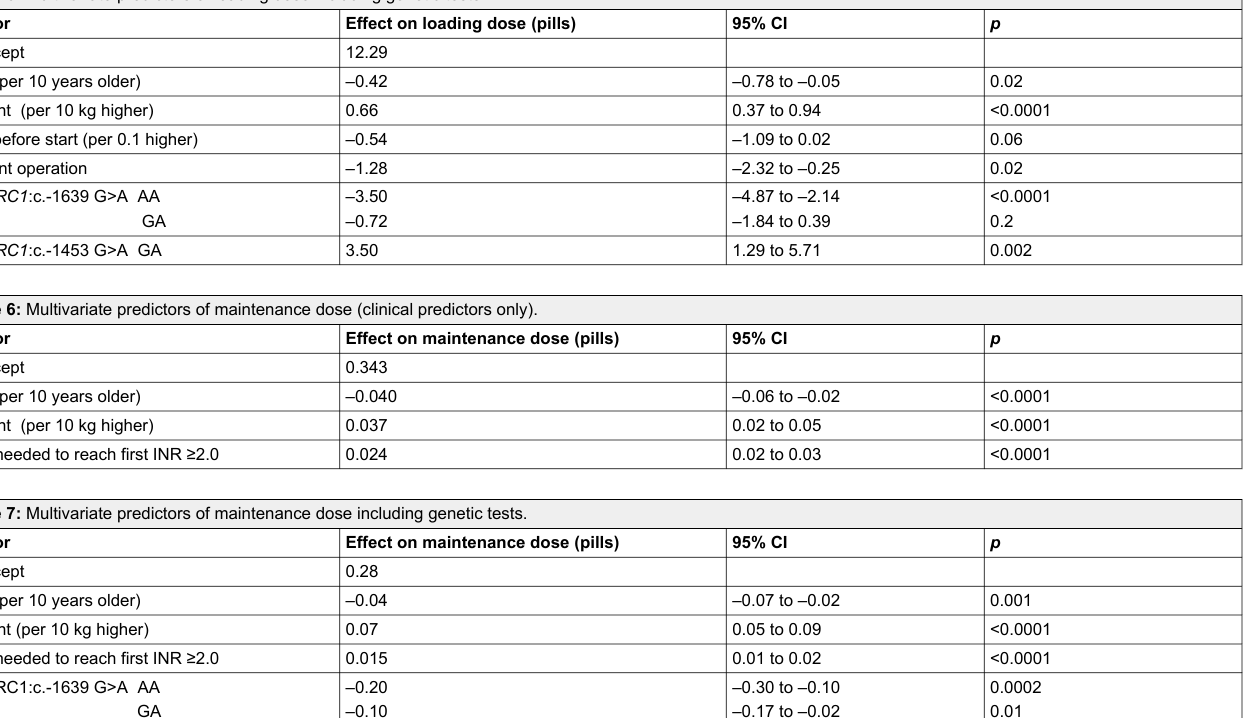
Table 5: Multivariate predictors of loading dose including genetic tests. Factor